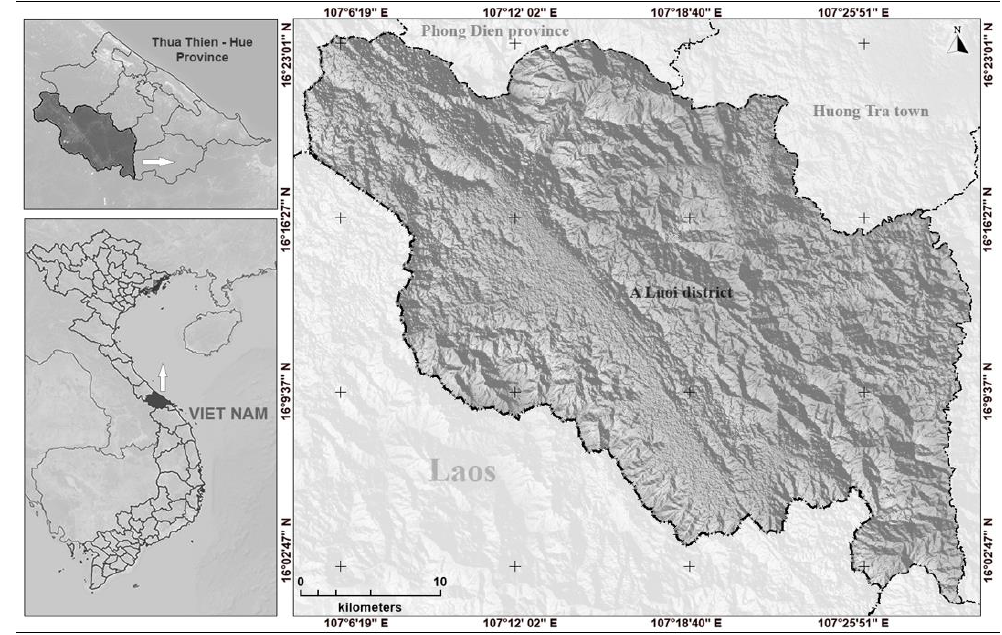
Figure 1. Location of the study areas (A Luoi district) in Thua Thien-Hue province,